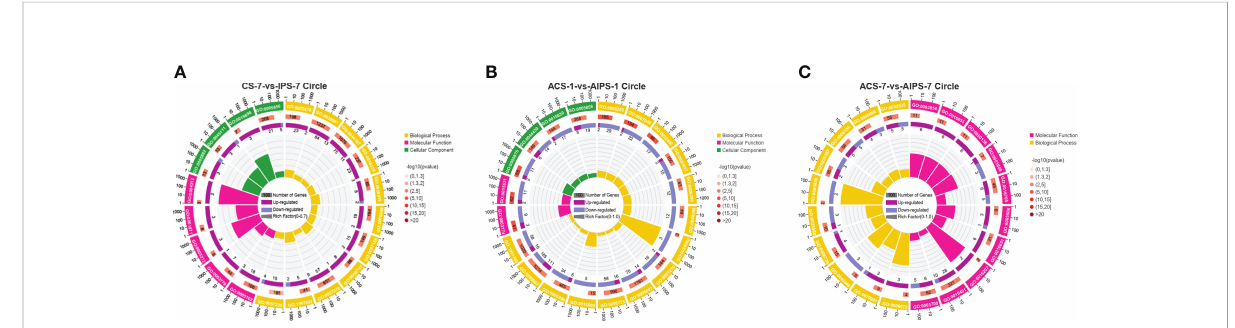
FIGURE 5 GO enrichment circle plot of Top 20 GO terms at 7 th post immunization day (A) and 1 st (B) and 7 th (C) post challenge day ( p < 0.05). The fi rst circle is the ID of the GO term, yellow represents the biological process, pink represents the molecular function, and green represents the cellular component. The second circle is the number of the GO term in the background genes and the p value. The third circle shows the proportion of up-regulated (deep purple) and down-regulated (blue) genes. The fourth circle shows the Rich Factor value of each GO term (Rich Factor value is the number of differential genes divided by the number of background genes in the GO